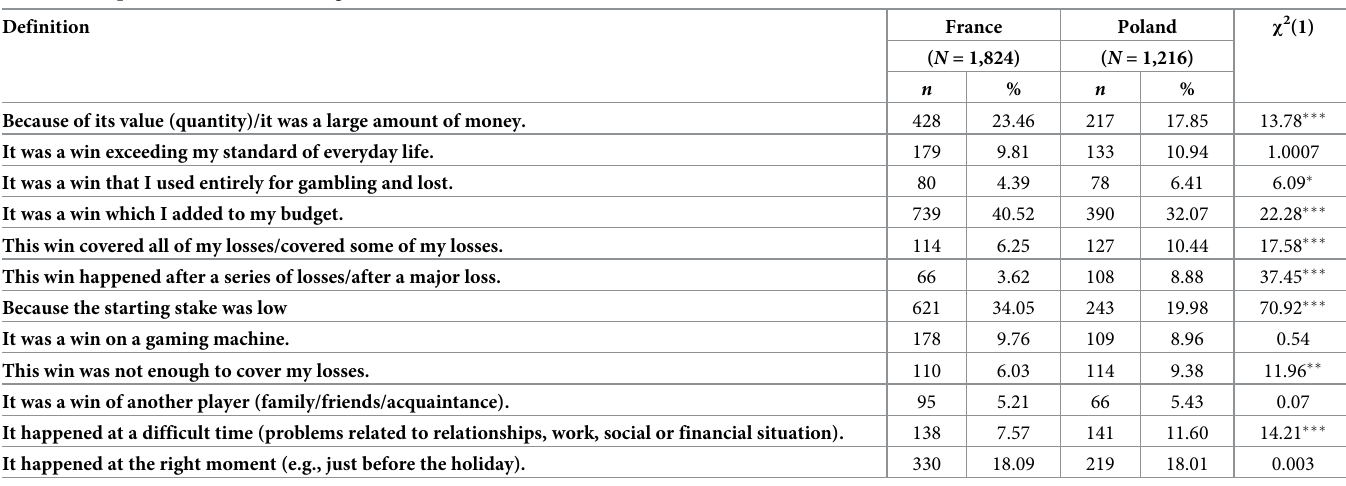
Table 3. Comparison of definitions of significant win chosen in both